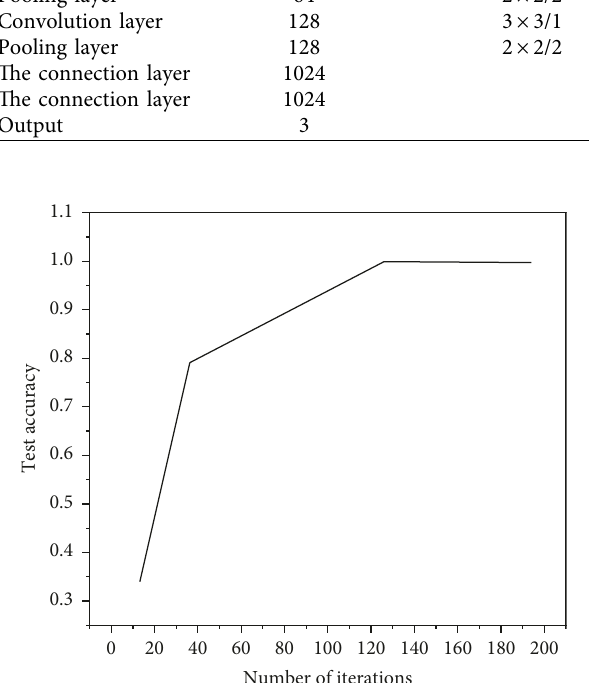
Figure 4: Comparison of recognition accuracy between Adadelta and different loss function